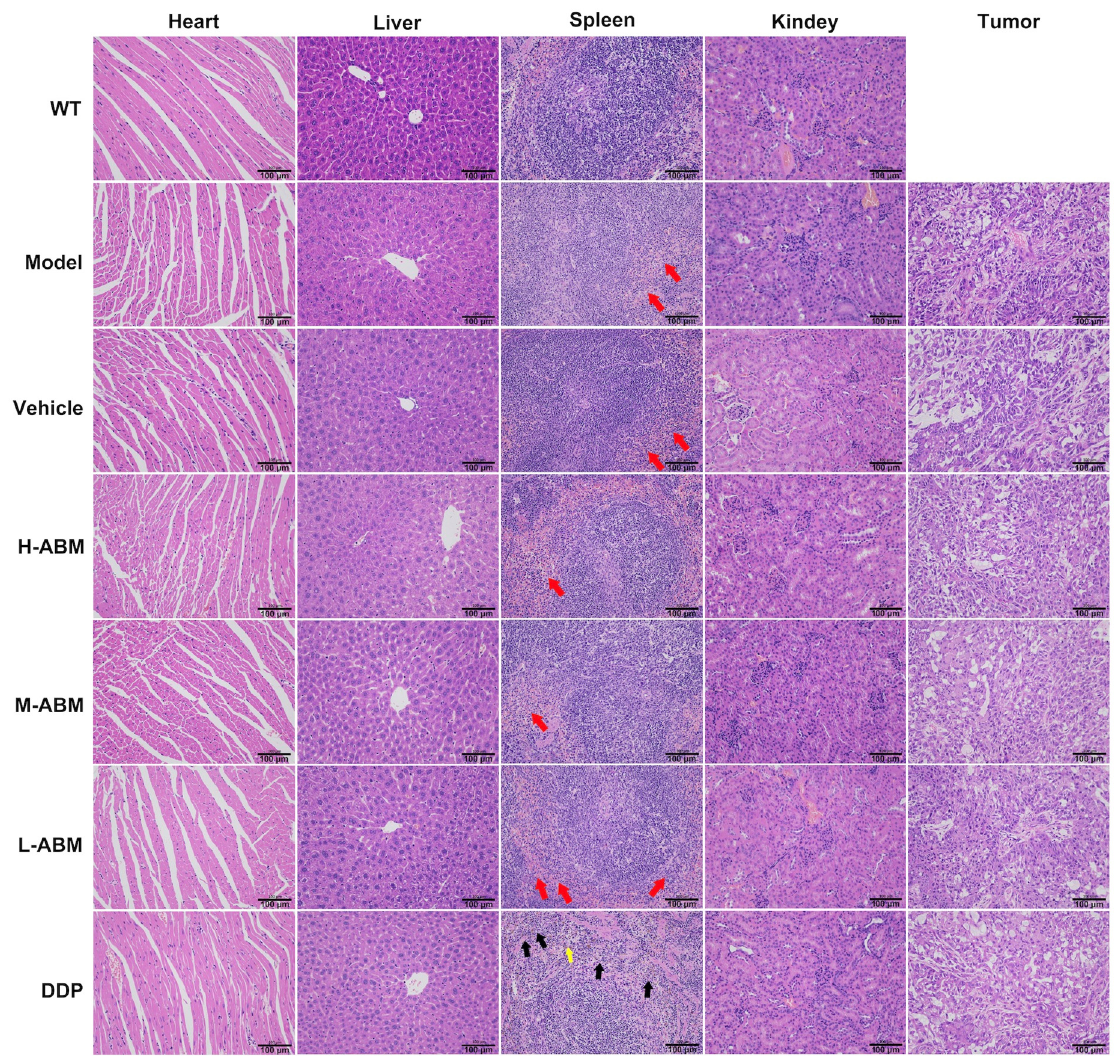
Figure 10. Histological observation of various tissues including heart, liver, spleen, kidney and tumor after hematoxylin and eosin (H&E) staining (Scale bars, 50 µ